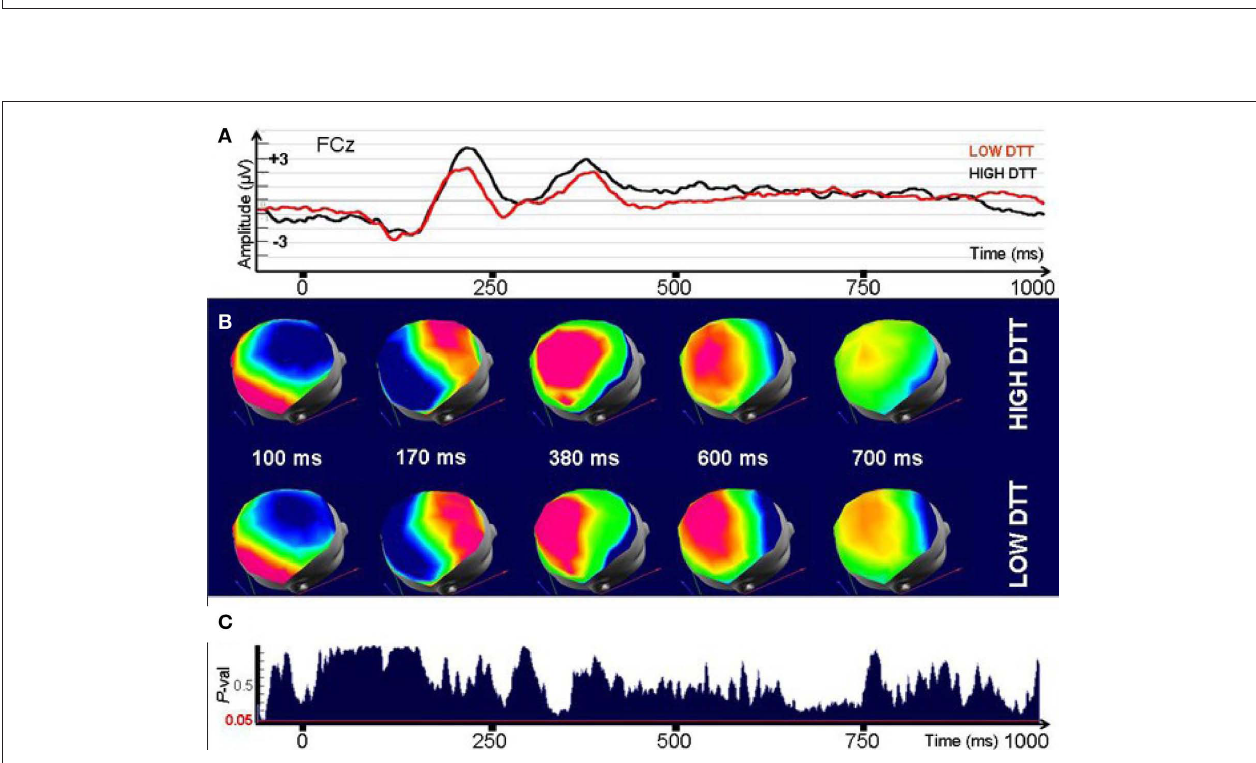
FiGurE A5 | Electrophysiological comparison between High and Low-DTT groups under neutral–negative outcomes. (A) Signals recorded at a fronto-central electrode (FCz) after presentation of the neutral–negative outcomes at time 0. (B) Evolution through time of the corresponding Event-Related Potential maps (C) P -value for a randomized MANOVA performed on the maps. Threshold for significant differences ( P < 0.05) is indicated by the red line. No significant differences are observed.